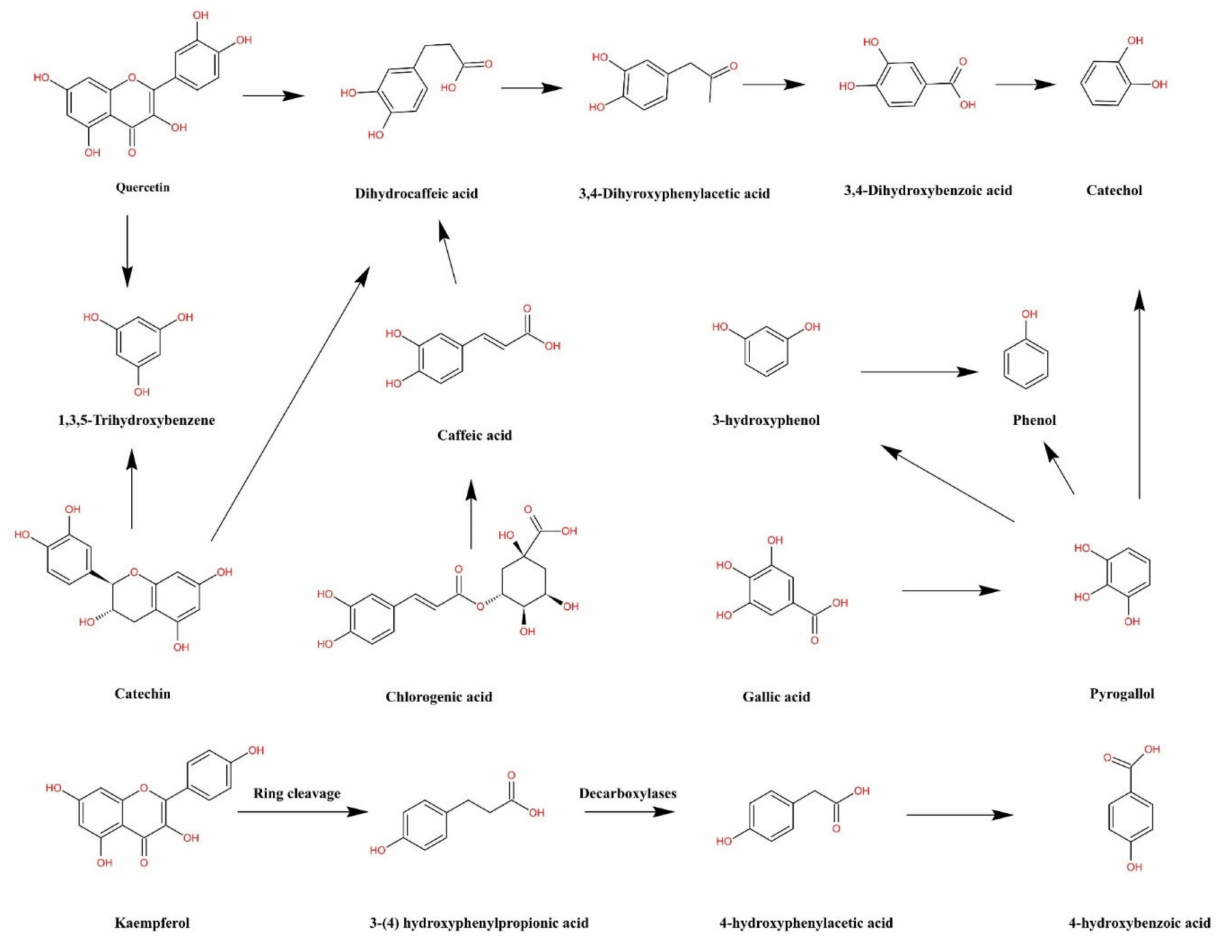
Figure 3. Possible digestion routes of the phenolic compounds in